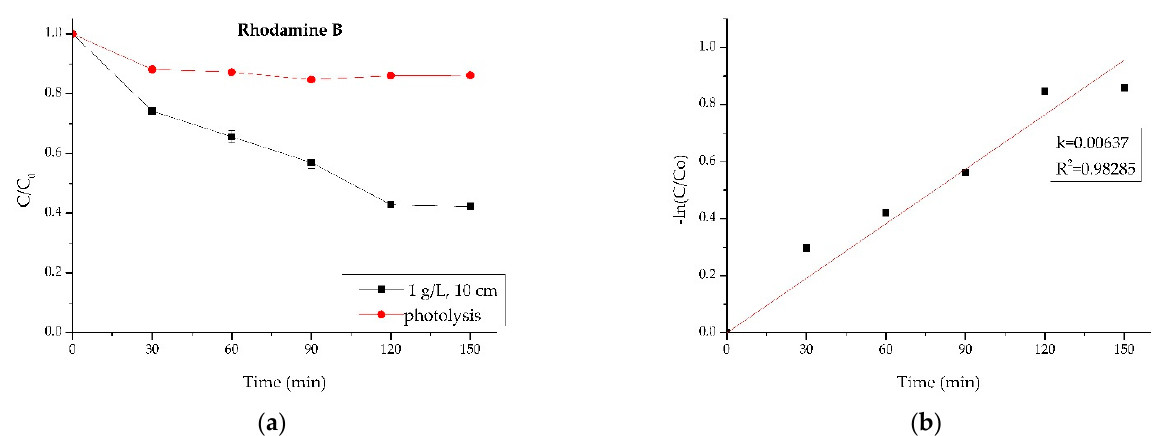
Figure 13. Experimental results when following the proposed photocatalytic protocol in ( a ) degra- dation rate and ( b ) photocatalytic kinetics. tion rate and ( b ) photocatalytic